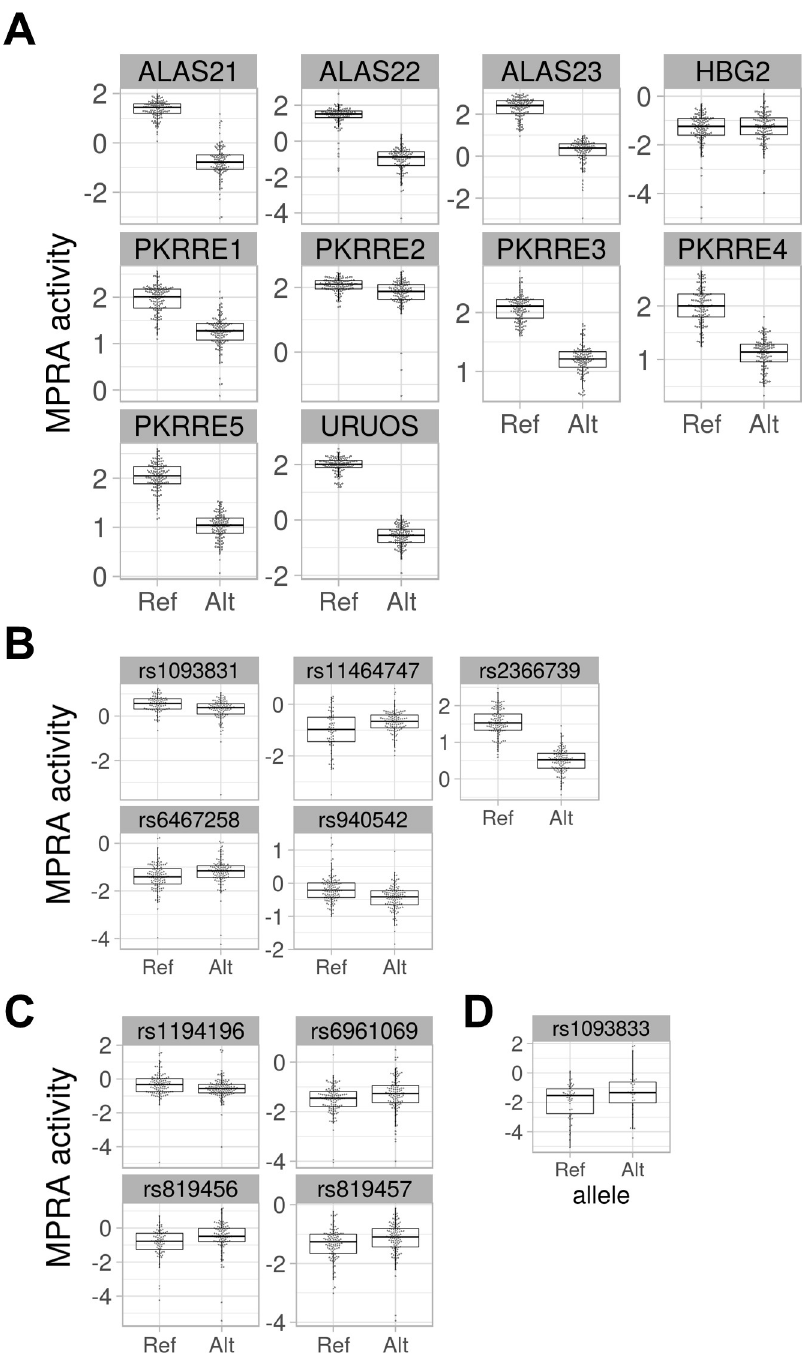
Fig 3. Results of MPRA assay of CD36 eQTL SNPs. (A) MPRA activity of positive control constructs. (B) MPRA activity of CD36 eQTL SNPs with significant transcription shifts identified by T-Test. (C) Additional CD36 variants with significant transcription shifts identified by U-Test. (D) Additional CD36 SNP with significant MPRA transcription shift identified by Bayesian analysis. of each control sequence (ALAS2-1, 2 and 3) containing original or disrupted GATA1 binding site. As predicted and shown previously the sequences with original binding site exhibited